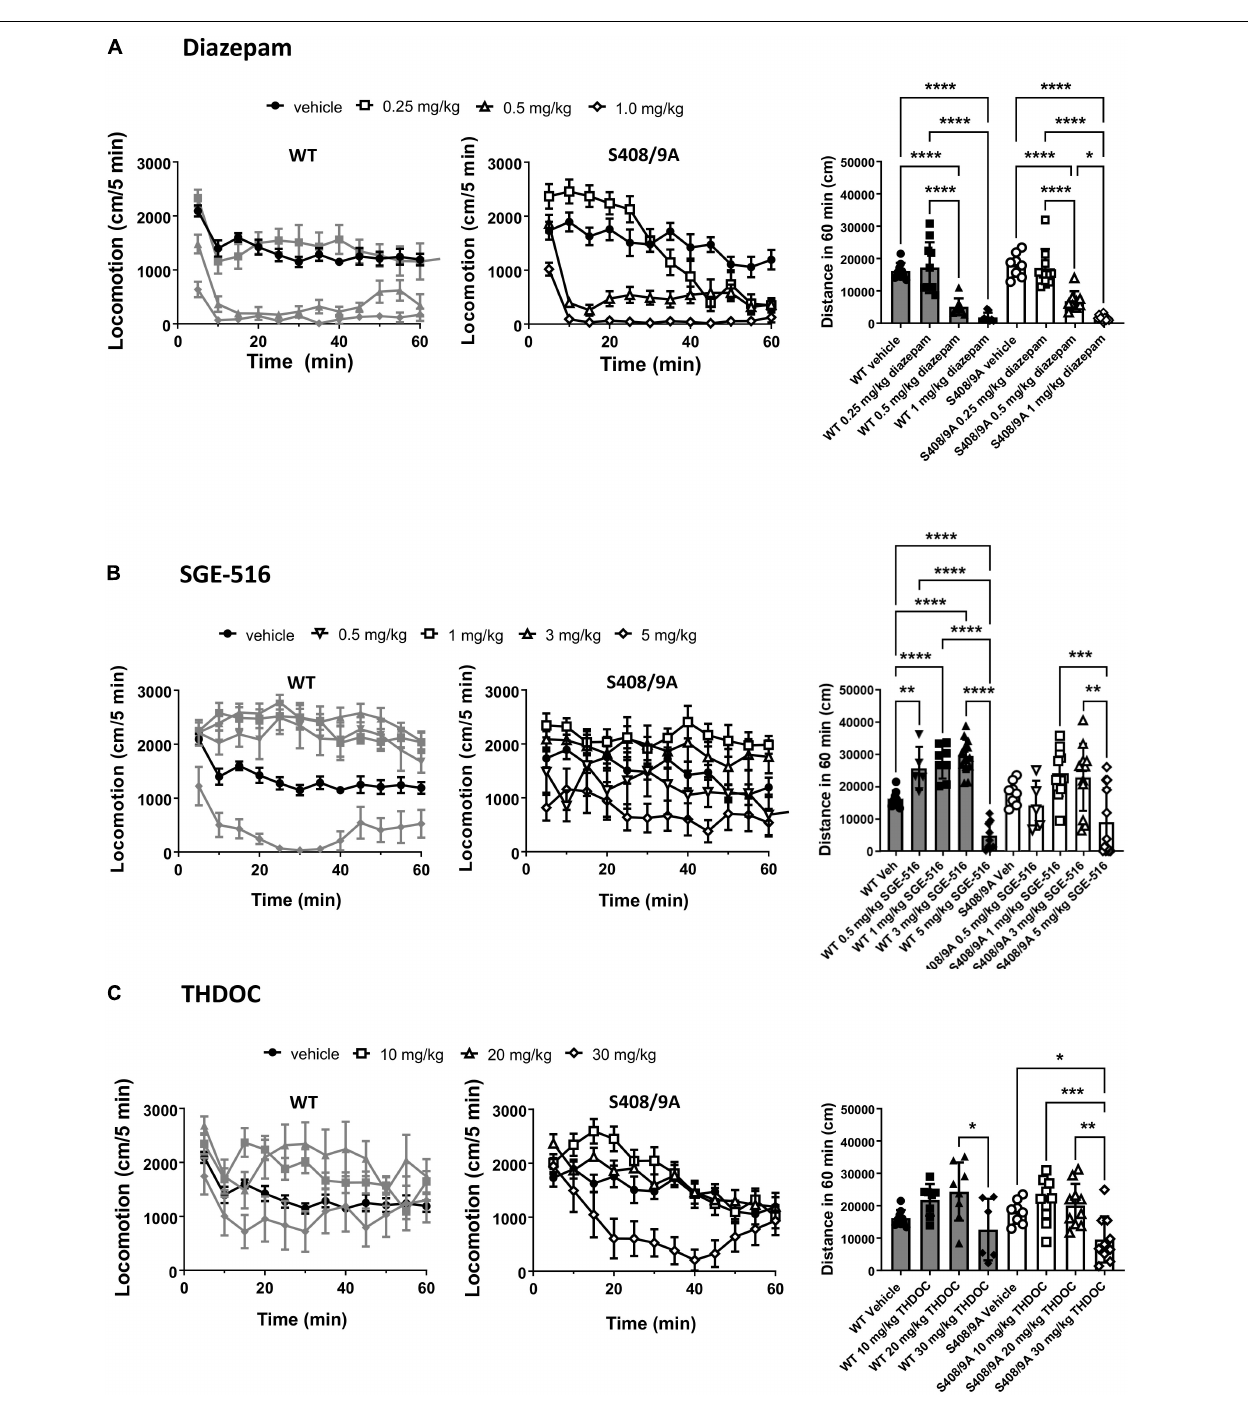
FIGURE 1 | S408/9A is not critical for sedative actions of NASs in the Open Field test. WT (black bars) and S408/9A (white bars) mice were injected i.p. with vehicle, 0.25–1 mg/kg Diazepam (A) , 1–5 mg/kg SGE-516 (B) , or 10–30 mg/kg THDOC (C) . 30 min later total distance traveled was measured for 60 min. All data represent mean ± S.D., * p ≤ 0.03, ** p ≤ 0.003, *** p ≤ 0.001, **** p < 0.0001.